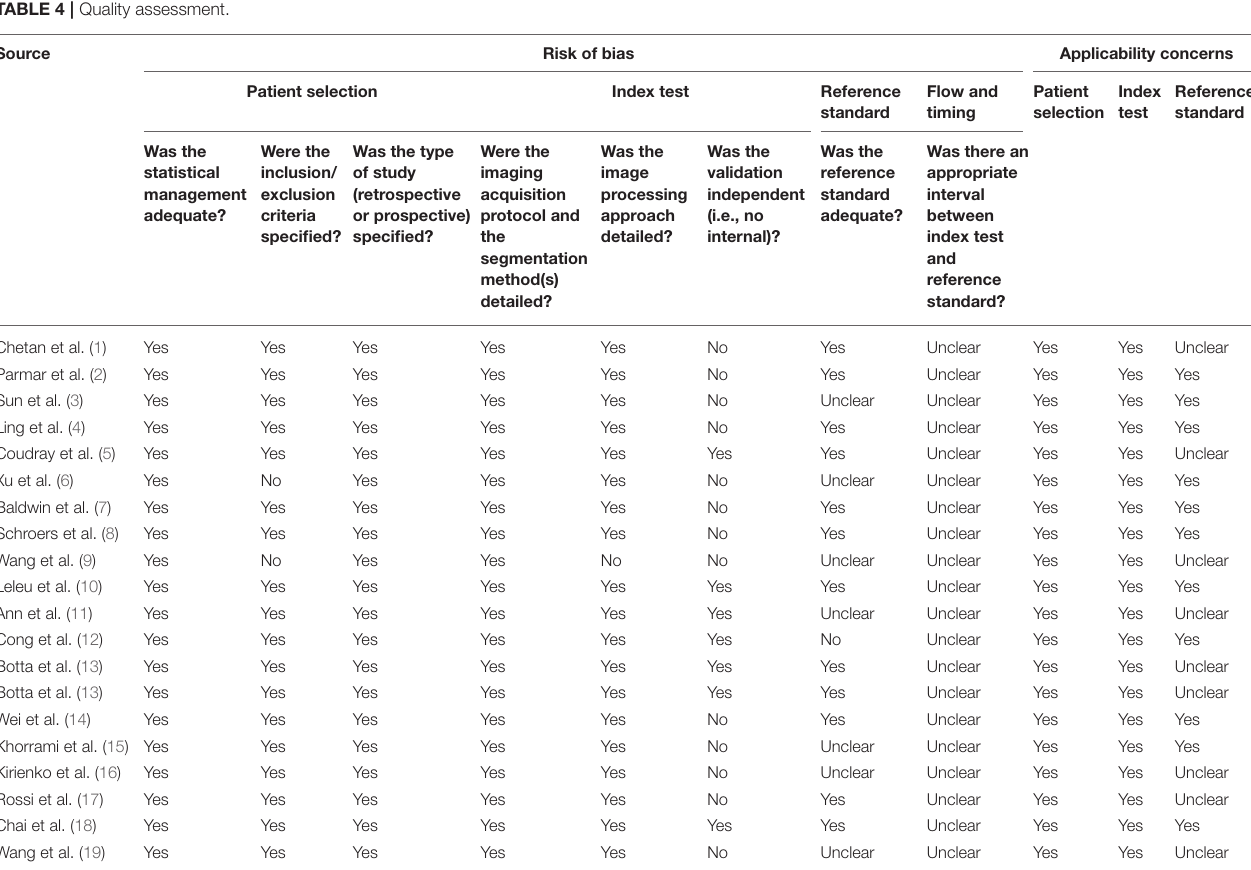
TABLE 4 | Quality